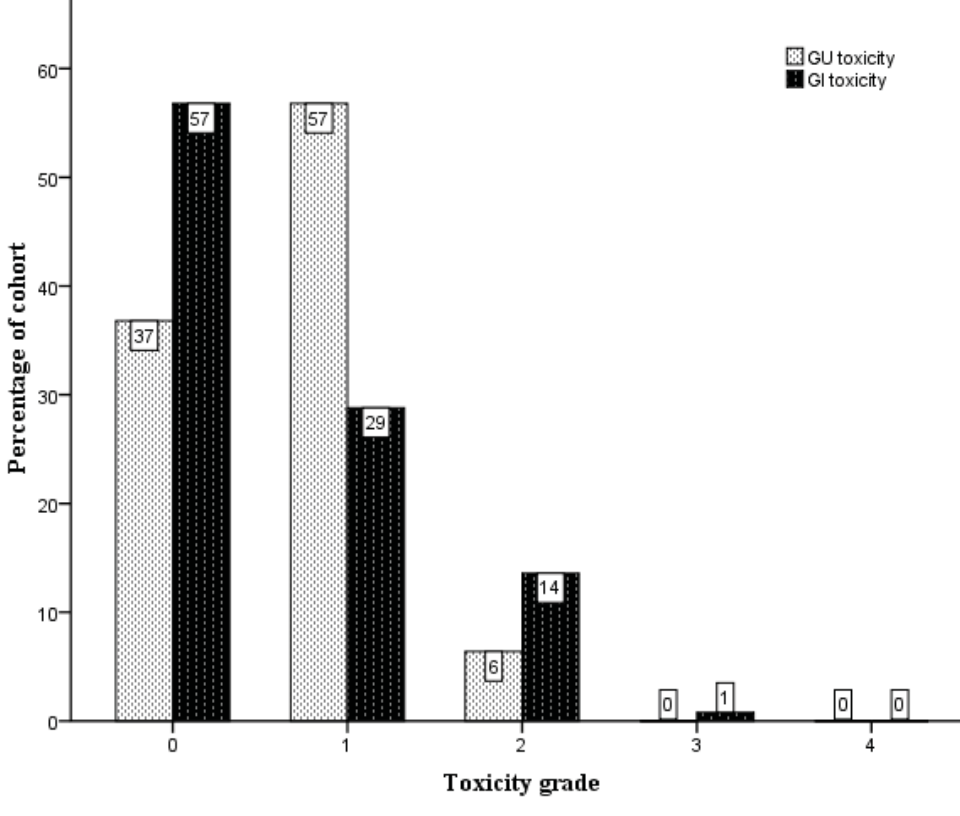
Figure 3. Crude incidences of late genitourinary (GU) and gastrointestinal (GI)